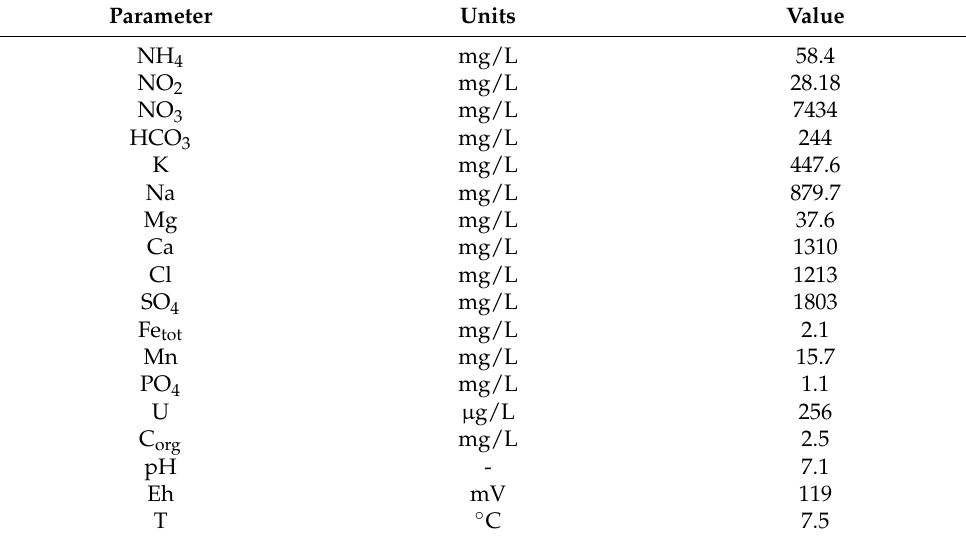
Table 1. Chemical composition of the polluted groundwater.